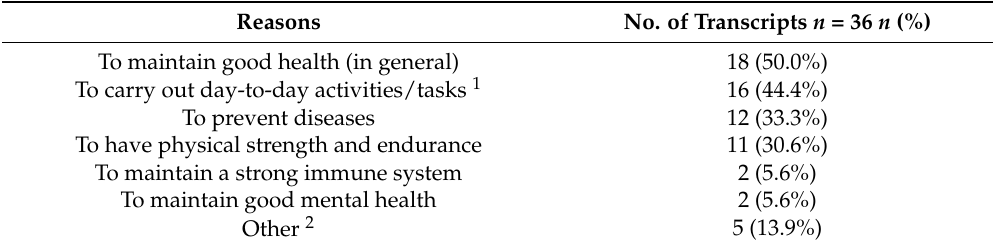
Table 3. Reasons for “ buena alimentaci ó n